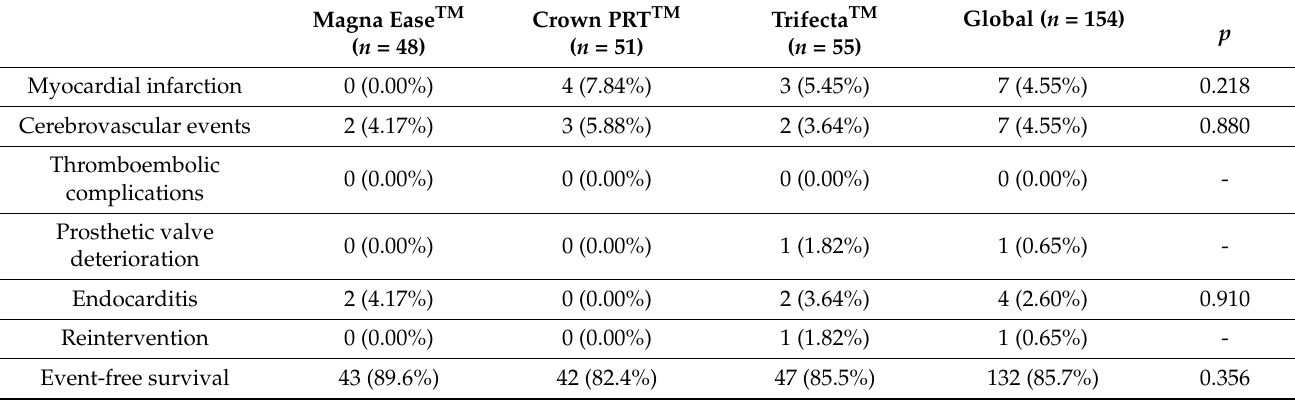
Table 5. Postoperative events at 12